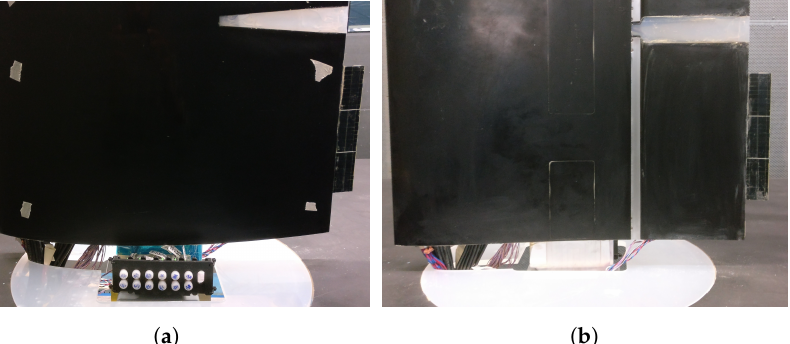
Figure 8. Zoomed-in images of module #1 of the test wing showing the module’s: ( a ) Upper surface (fixed) and ( b ) Lower surface (sliding). ( a ) The optical fiber connector hub at the bottom.